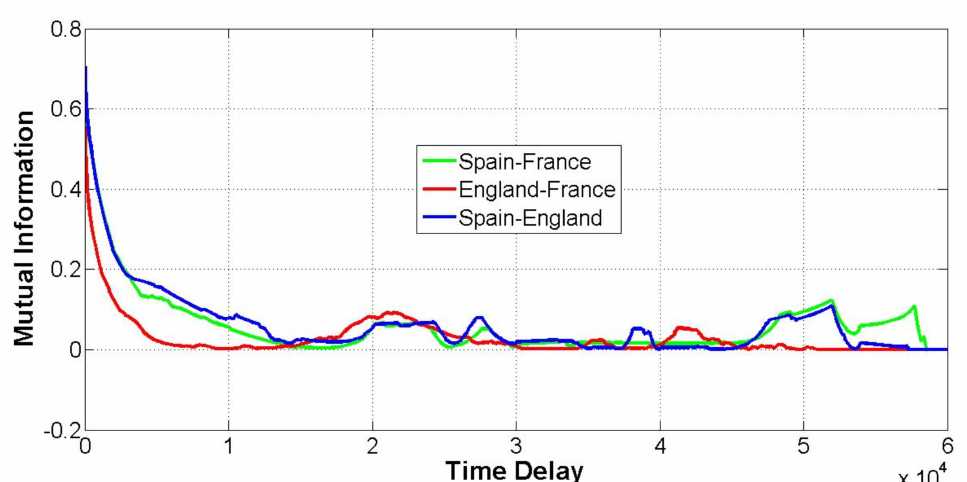
Figure 2. Time delayed mutual information I ( x , x − λ ) [47] for the discrete time series corresponding to the nodes of the network representing the countries of Spain, France, and England. The time delay λ is expressed in days ranging from 1 up to approximately 164 years, a value that ensures the statistical independence of the stochastic processes and its delayed versions representing the temporal evolution of the political relationships of the aforementioned countries covering the period from 1816 till 2007. The correlations of the three graphs for a certain range of values of the delay evidence the existence of historical events that directly or indirectly affected the political relationships between those